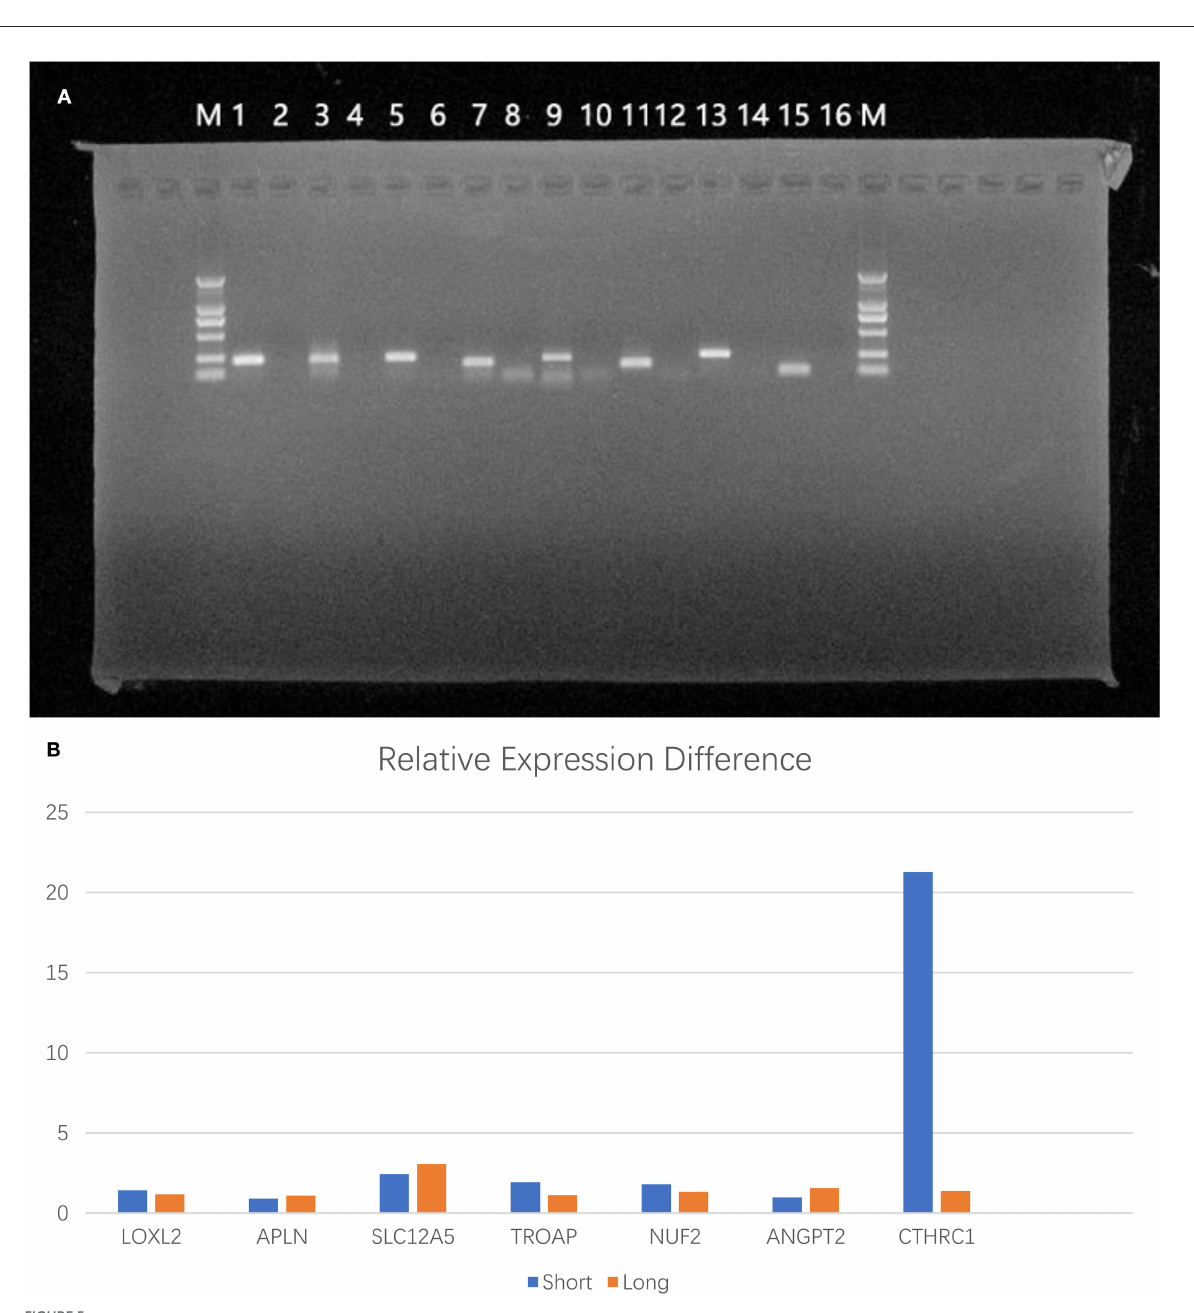
FIGURE5 Validation of RNA expression differences between tumor tissues of patients. (A) Electropherogram of PCR products (M: DL2000; 1: GAPDH; 2: GAPDH negative control; 3: LOXL2; 4: LOXL2 negative control; 5: APLN; 6: APLN negative control; 7: SLC12A5; 8: SLC12A5 negative control; 9: TROAP; 10: TROAP negative control; 11: ANGPT2; 12: negative control; 13: NUF2; 14: NUF2 negative control; 15: CTHRC1; 16: CTHRC1 negative control). (B) The differences in mean relative gene expression between the two